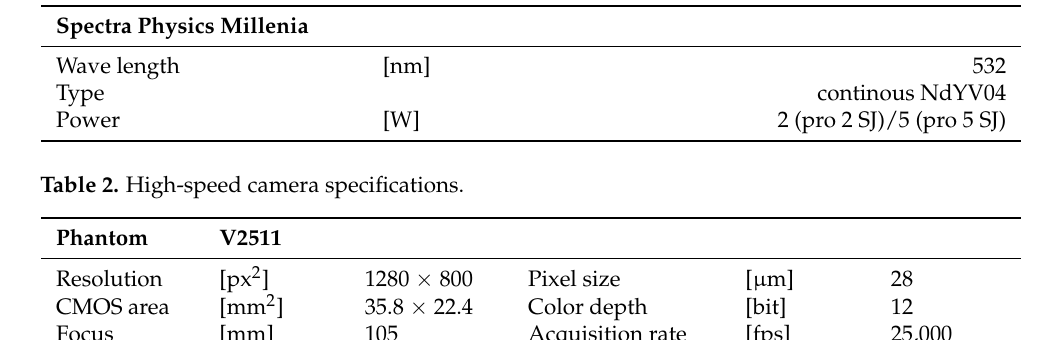
Table 1. Laser I and II specifications.